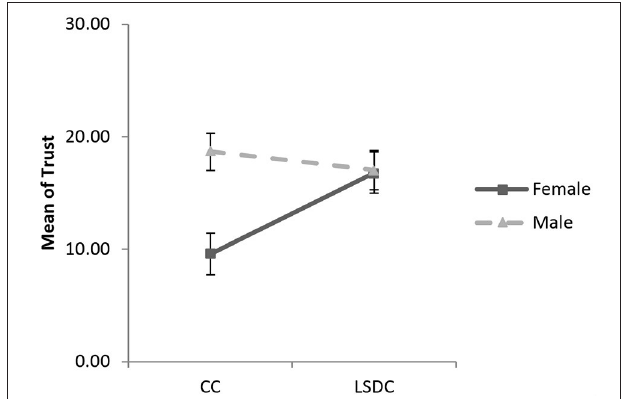
FIGURE 4 | Estimated marginal means of trust (in point) in the control condition (CC) and low social distance condition (LSDC) in Study 2. Error bar is the standard